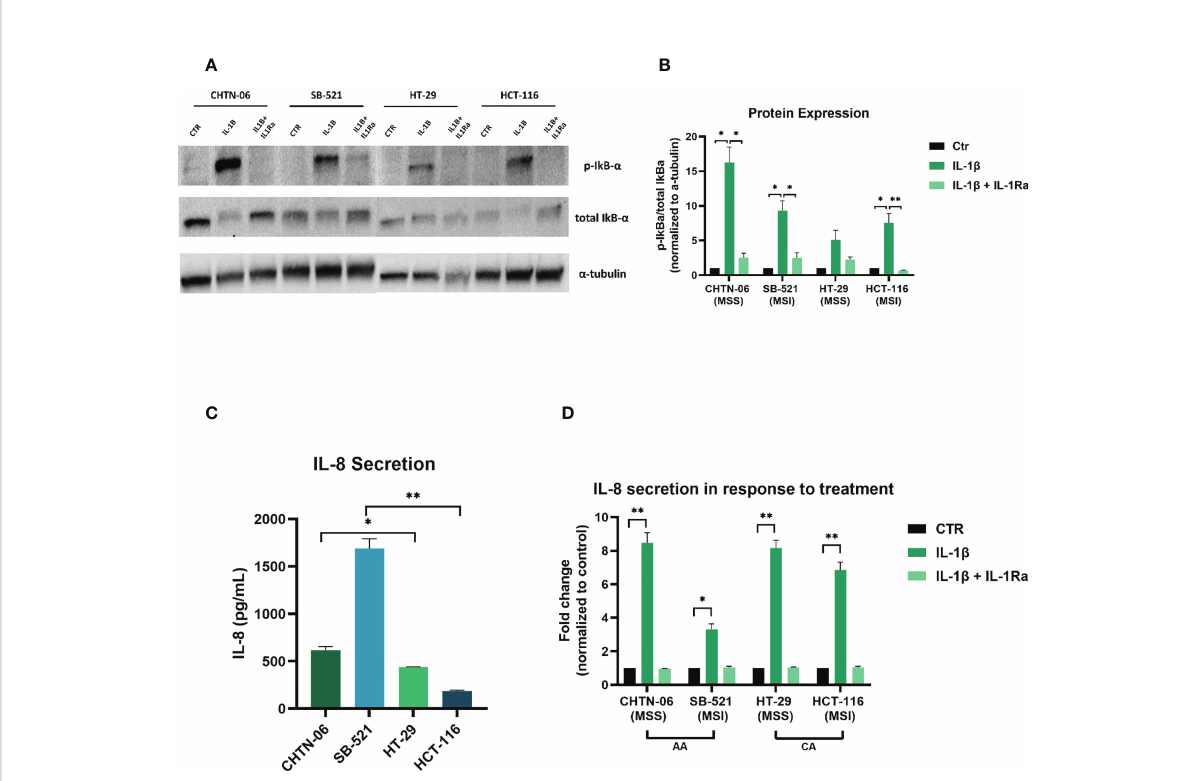
FIGURE 7 IL-1Ra prevents activation of IL-1 b pathway in colon cancer cell lines. Treatment with IL-1Ra prevents phosphorylation of phospho-IkB a and secretion of IL-8. (A) Representative images of Western Blot analysis following treatment of cells with either IL-1 b alone or in combination with IL-1Ra. (B) Graphic visualization of protein expression for phospho-IkB a . Values are expressed as phospho-IkB a /total IkB a ratio, after being normalized to normalized to loading control ( a -tubulin). (C) Baseline IL-8 secretion in AA and CA colon cancer cell lines. (D) Changes in IL-8 secretion following treatment with IL-1 b or IL-1 b + IL-1Ra Data are representative of three independent experiments. Error bars represent SEM. *p<0.05,